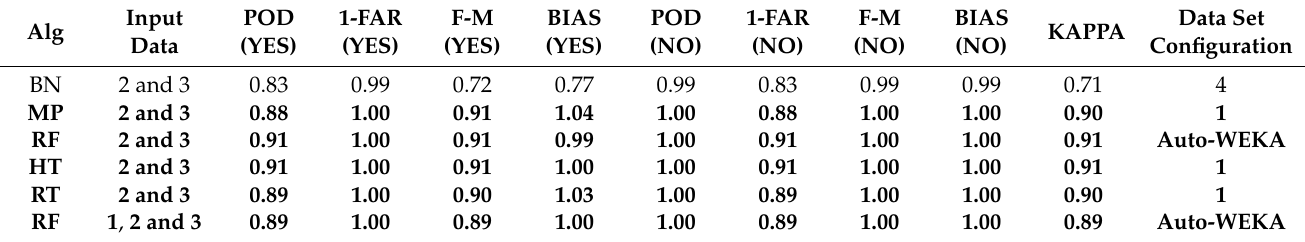
Table 3. Statistical test results of 15 min Vis forecasts ≤ 4500 m for the five algorithms (Alg) selected with input from SODAR (source 1), ASWS (source 2) and observer (source 3). The satisfactory algorithm result is in bold. Alg